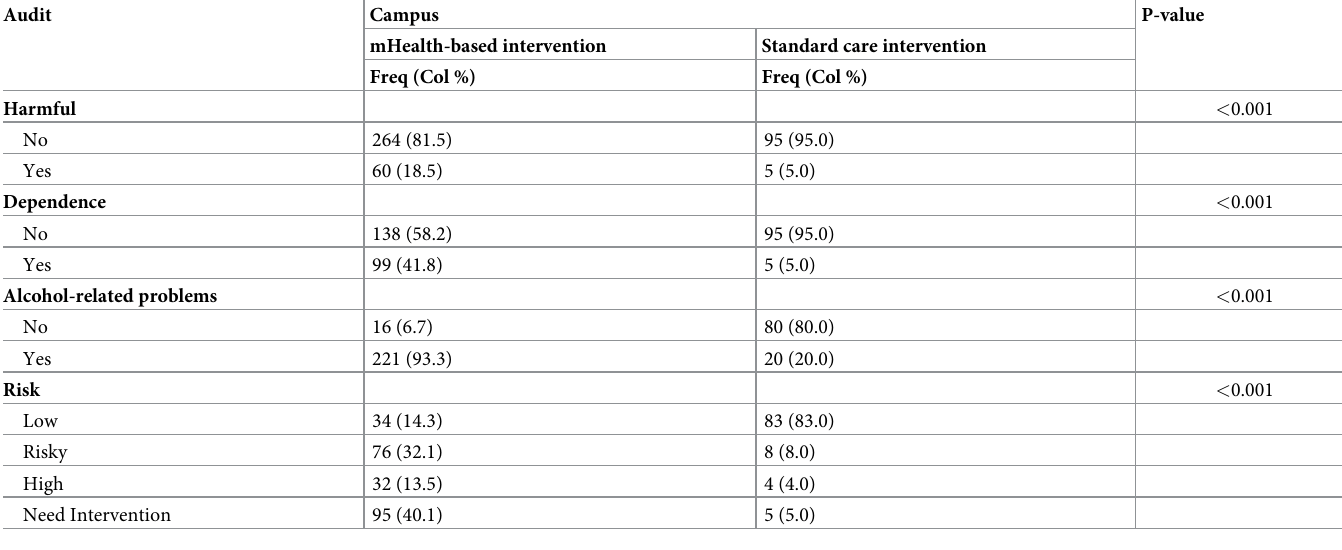
Table 5. Risk assessment for Alcohol Use Disorders by mentees